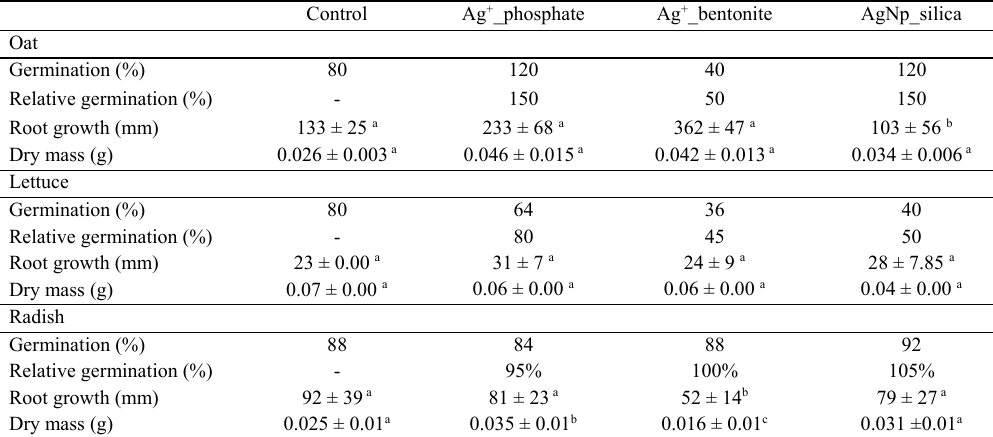
Table 3: Oat, lettuce and radish germination (%), relative germination (%), comparing loaded soil with the control), root growth (mm) and dry mass (g)